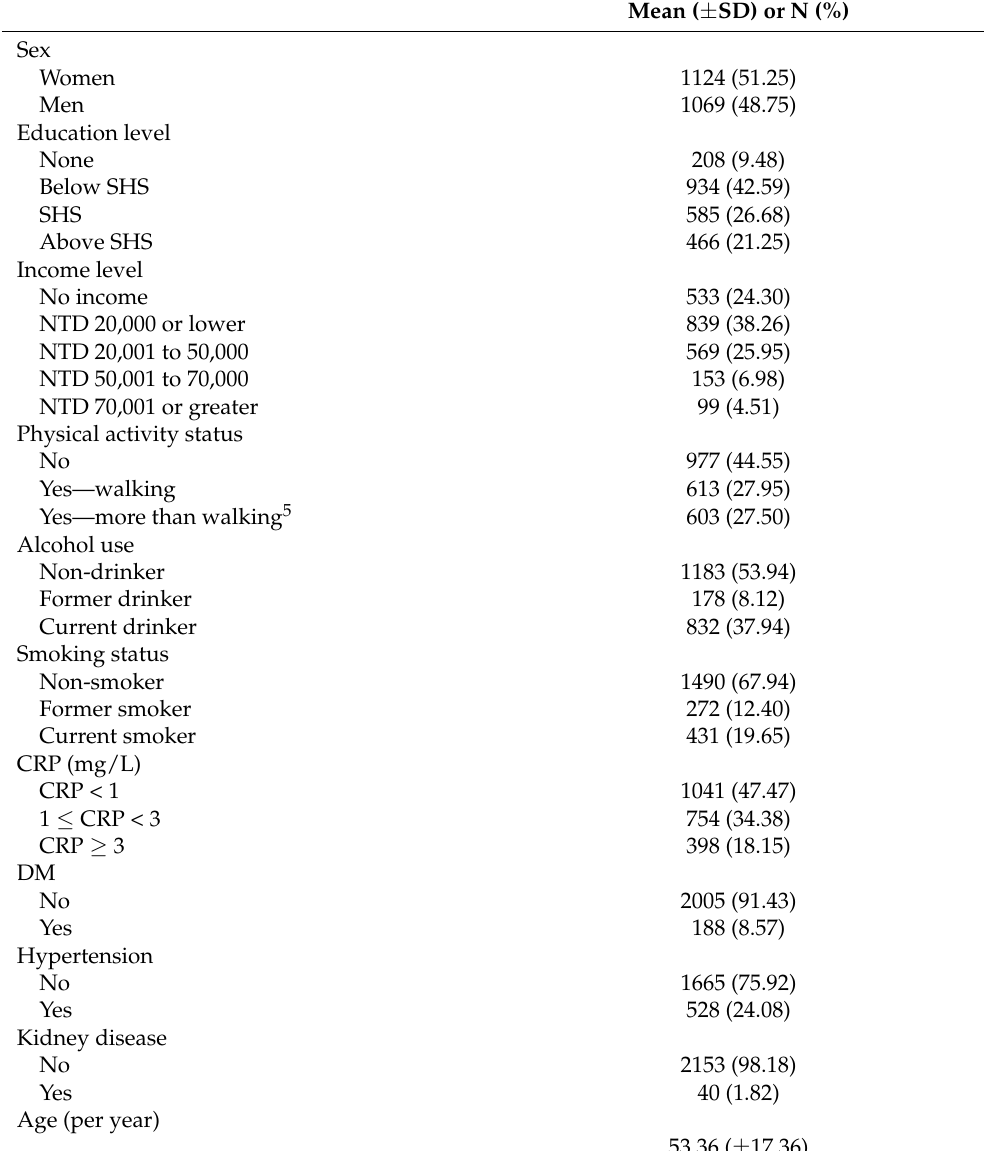
Table 1. Participant characteristics (N =